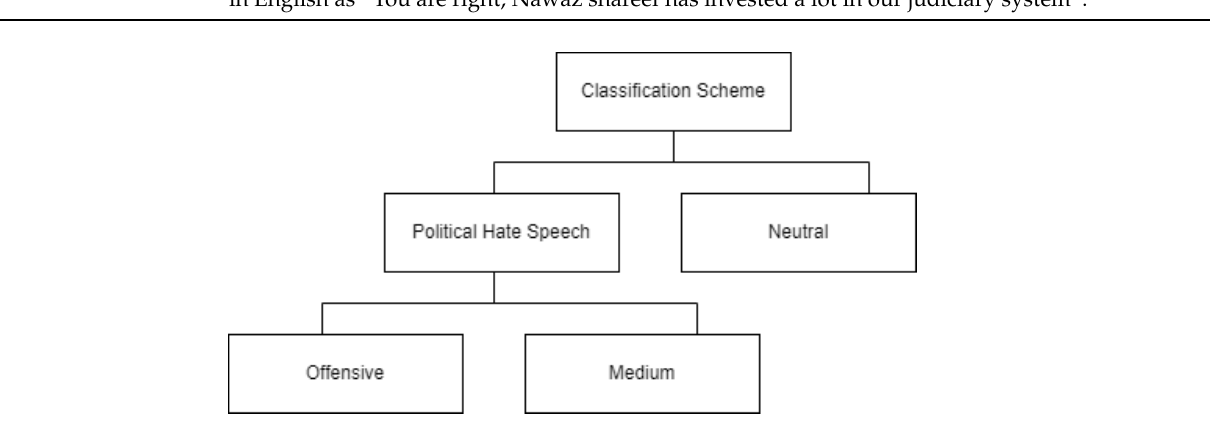
Figure 8. Taxonomy diagram of political hate speech